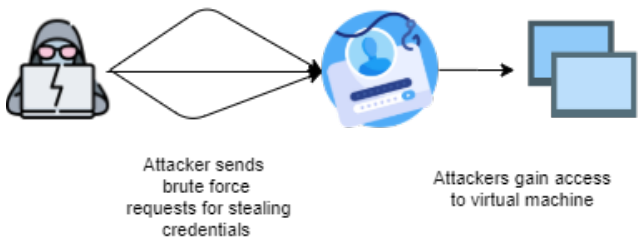
Figure 14. Graphical representation of a virtual machine rollback attack [100].